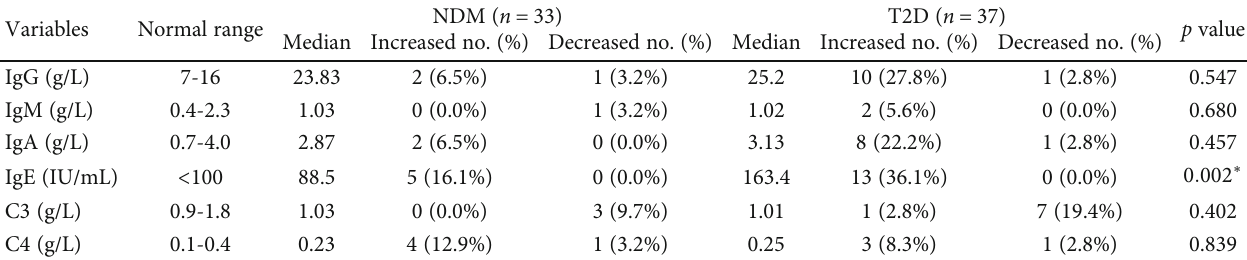
Table 4: Serum levels of immunoglobulins and complements in patients with and without type 2 diabetes.